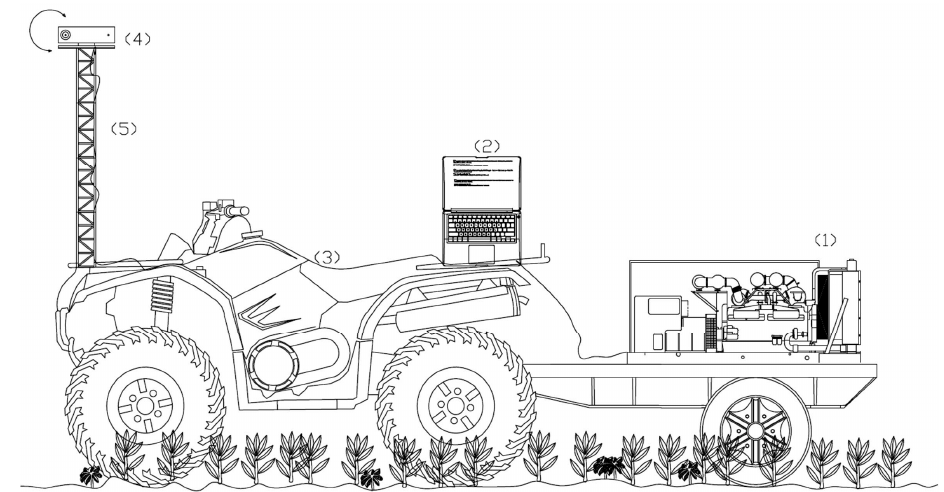
Figure 1. Schematic design of the system with the components integrated for maize-weed detection. (1) Portable gasoline generator; (2) laptop; (3) ATV; (4) Kinect v2 sensor; (5) support structure.